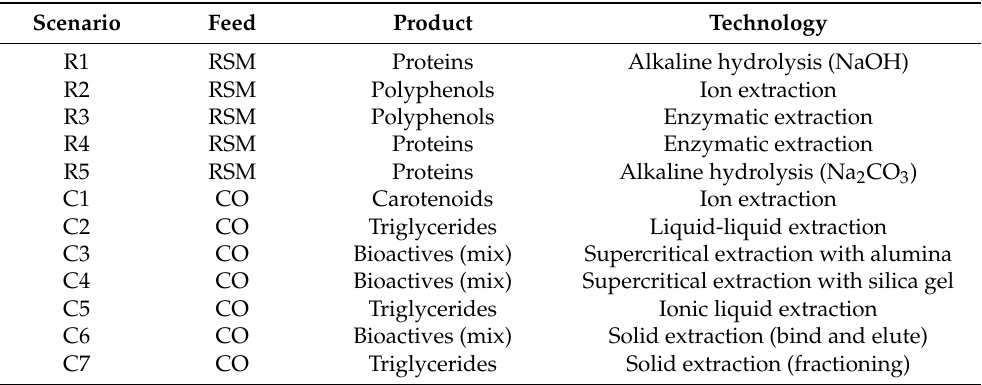
Table 1. Scenarios from the selected case studies (rapeseed meal and corn oil valorization) used for validating the proposed sustainability potential assessment